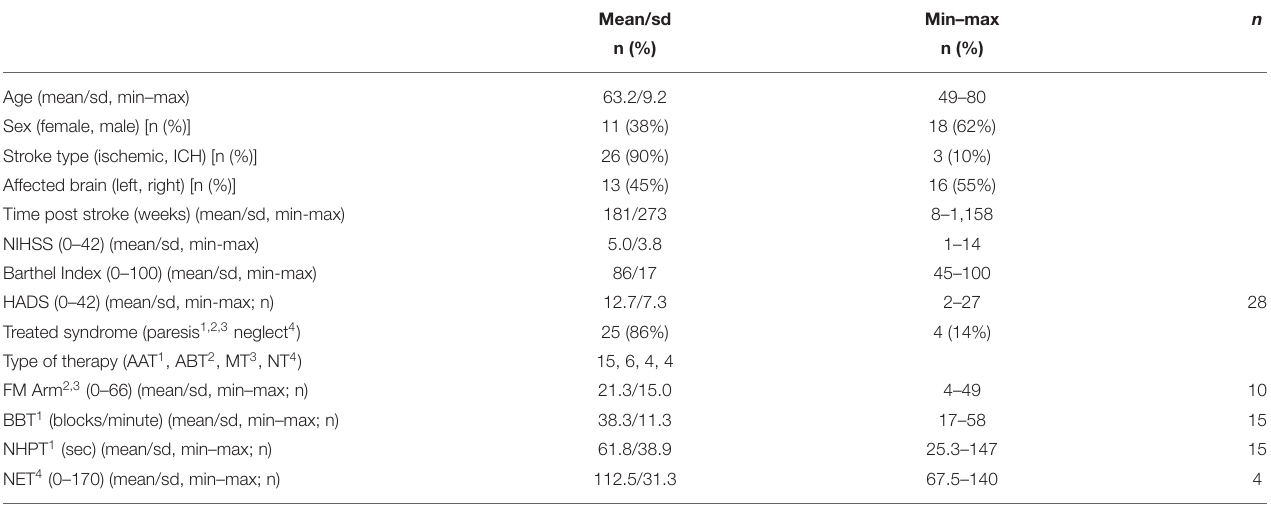
TABLE 2 | Study population characteristics and type of training ( n =